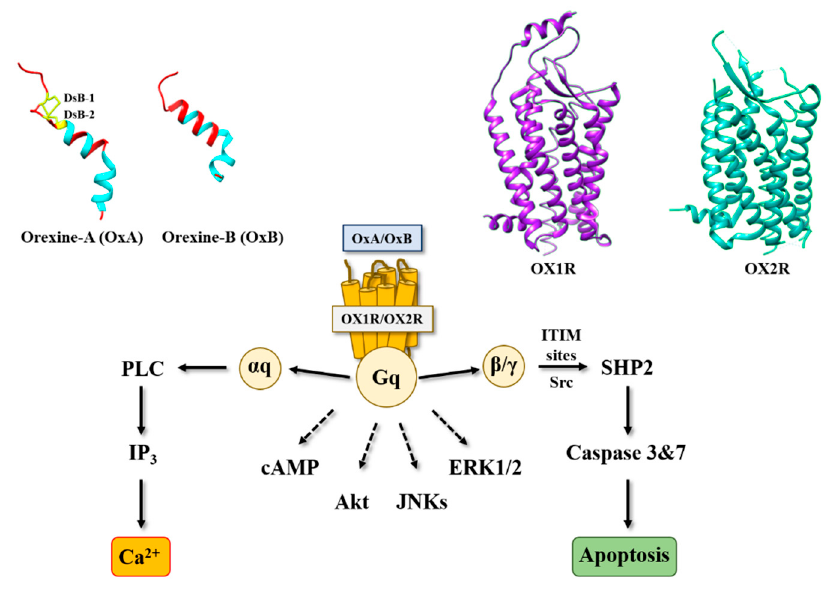
Figure 1. Structure of orexins and their receptors and main signaling pathways activated by orexins in cancer cells. DsB, disulfide bridge; IP3, inositol tri-phosphate; PLC, phospholipase; SHP2, Src homology 2 (SH2) domains of SH2-containing phosphatase 2; cAMP, cyclic adenosine monophos- phate; Akt, protein kinase B; JNKs, c-jun N-terminal kinases; ERK1/2, extracellular signal-regulated kinase 1 and 2; ITIM, immunoreceptor tyrosine-based motifs; Src, Src kinases.